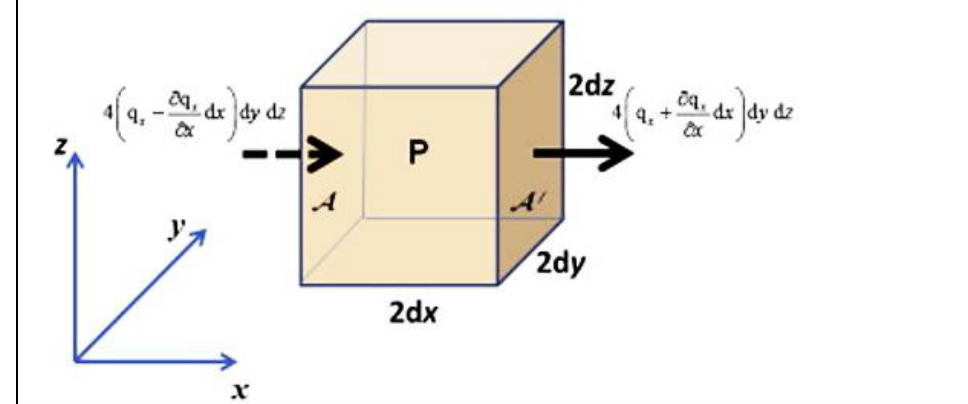
Figure 15. Heat flow in the x-direction through an element of volume at P.